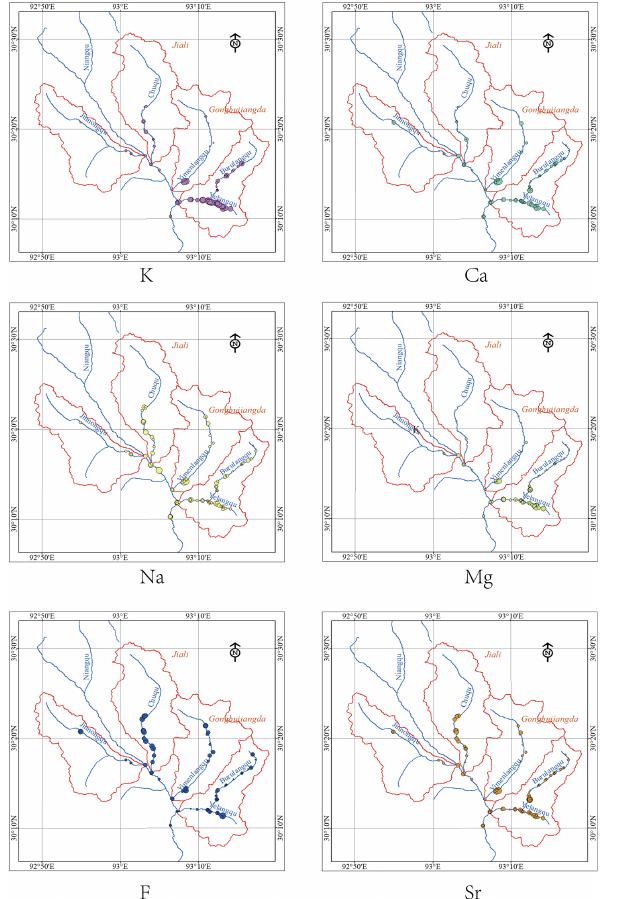
Figure 8. Geochemical elements distribution